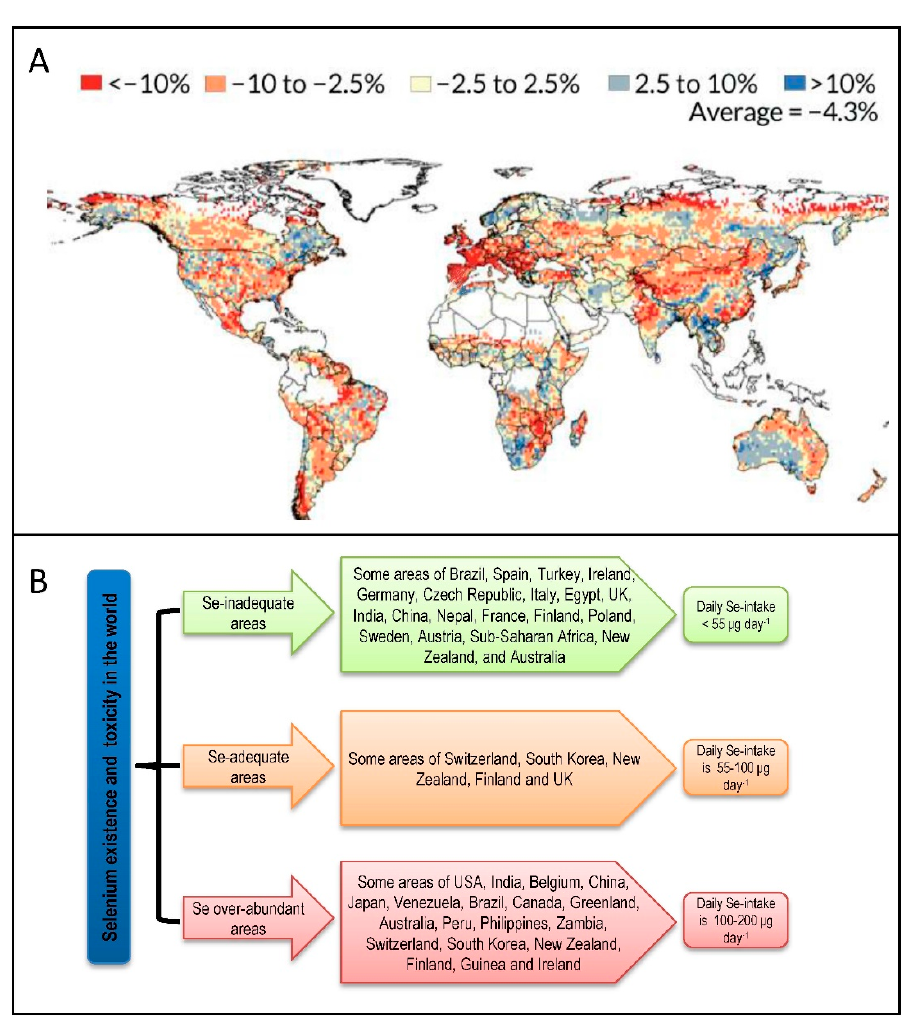
Figure 3. ( A ) Predicted percent changes in soil Se concentration from 1980–1999, 2080–2099. ( B ) Overview of Se occurrence and toxicity in various areas of the world based on human population and soil Se-availability. Source: LSA Honors Physics [89]; Hasanuzzaman et al. [21] (with permission from Elsevier).